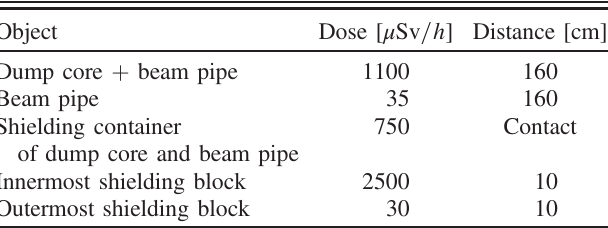
TABLE II. Results of the dose rate measurements [ μ Sv = h] performed on the main components of the original dump core- shielding assembly as they were being extracted from the cavity [24].